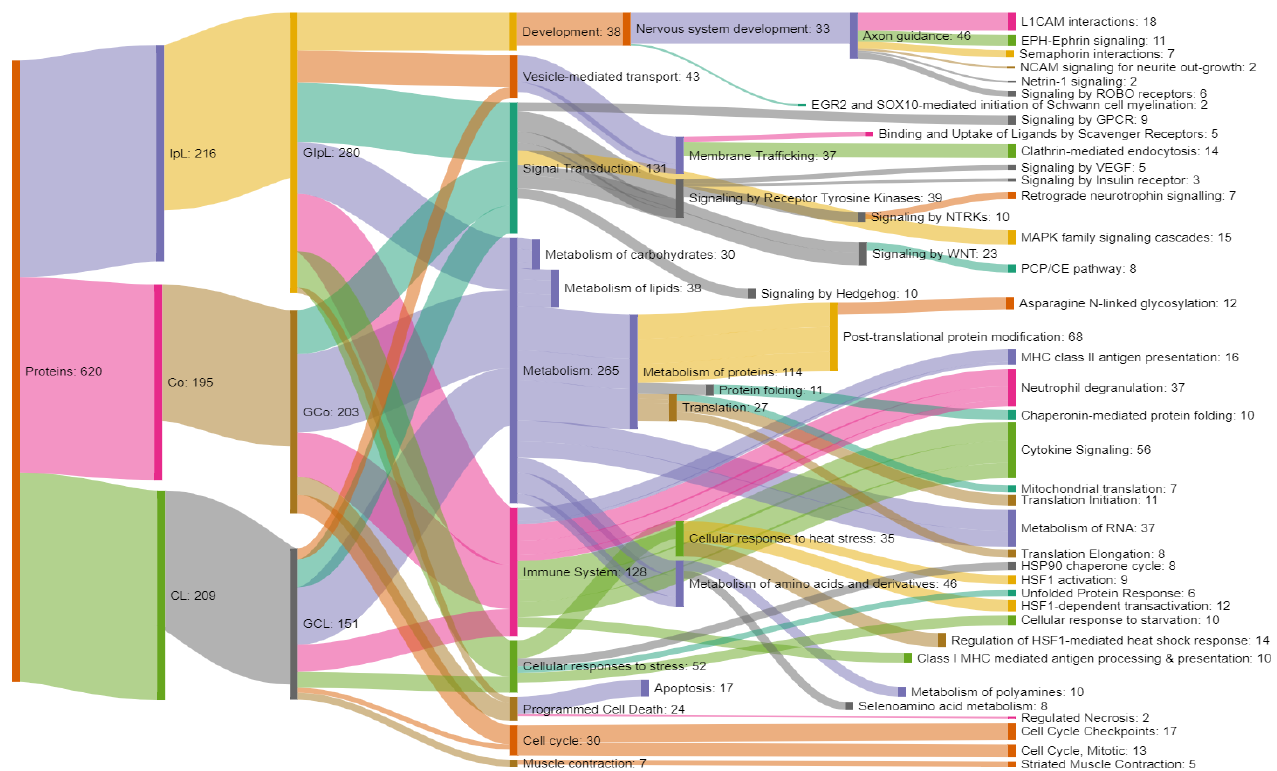
Figure 5. Genes of identified porcine brain proteins in the corresponding biological processes in the REACTOME: proteins — proteins unique for IH brain samples; IpL, proteins unique to the ipsilateral hemisphere; CL, proteins unique to the contralateral hemisphere; GIpL, co-proteins common to the ipsi- and contralateral hemispheres; and GCL, genes encoding the expression of proteins unique to the ipsilateral and contralateral hemispheres (Co are genes common to both hemispheres), for which a match was found in the REACTOME system.